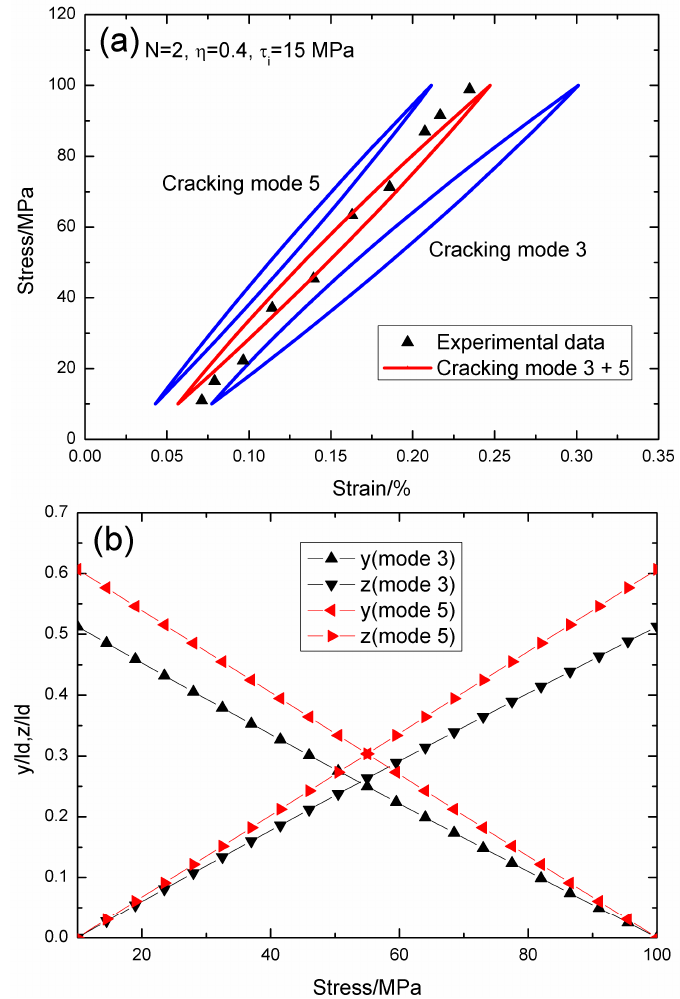
Figure 7. ( a ) The theoretical and experimental hysteresis loops; and ( b ) the interface slip lengths, i.e. , y / l d and z / l d , of matrix cracking modes 3 and 5 of 2D woven SiC/SiC composite under σ max = 100 MPa at 1000 °C in steam and a loading frequency of 1.0 Hz when N =